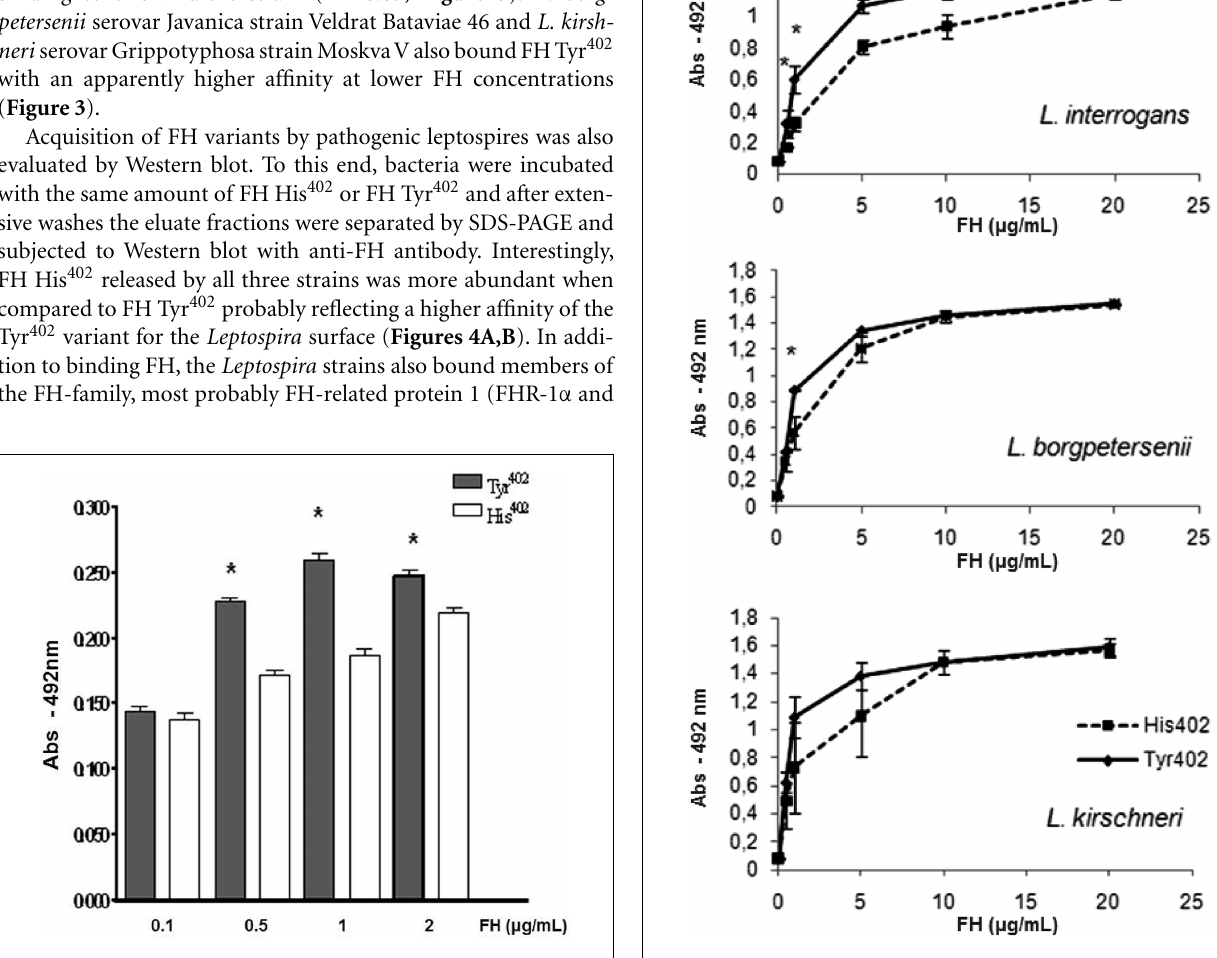
FIGURE 2 | Dose-dependent binding of FH variants to L. interrogans serovar Pomona strain Fromm . L. interrogans were incubated with increasing amounts of purified FH His 420 or FHTyr 420 (0.1–2 μ g/ml) and then immobilized on microtiter wells.The binding was assessed using a polyclonal anti-human FH. Each point represents the mean absorbance value at 492nm ± the SD of three independent experiments. * P ≤ 0.05 (Student’s two-tailed t -test). Both variants of FH were purified by gel filtration and affinity chromatography.